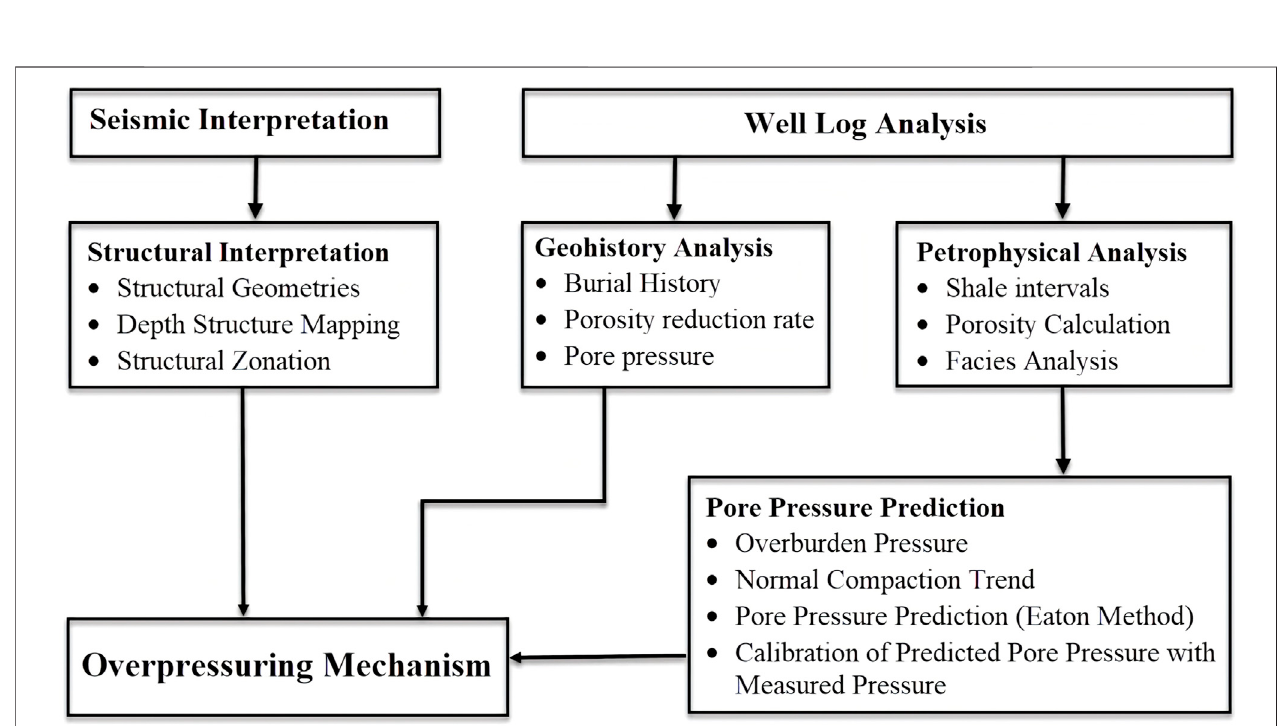
FIGURE 3 | Technical roadmap of research study showing adopted methodology work fl ow for pore pressure prediction in eastern Potwar.